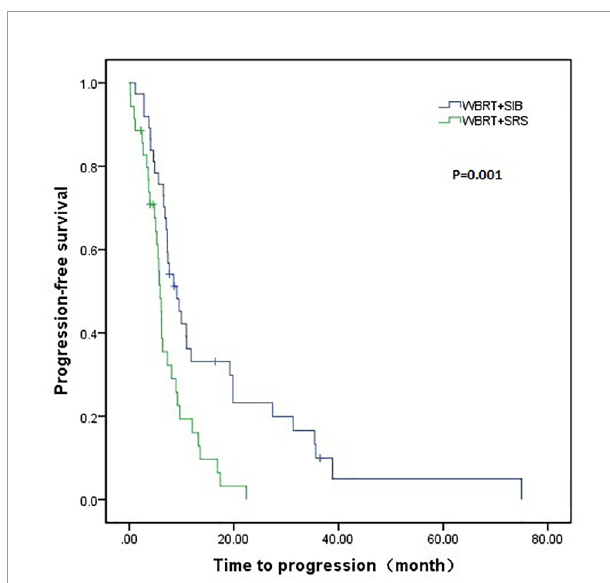
FIGURE 1 | Comparison of intracranial progression-free survival between WBRT + SIB and WBRT + SRS.